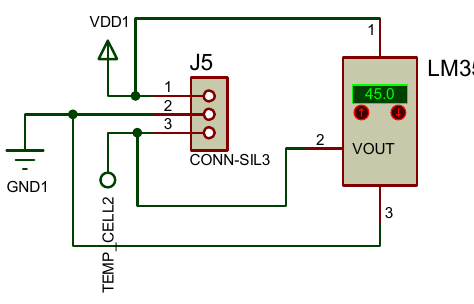
Figure 20. Temperature sensor setup.